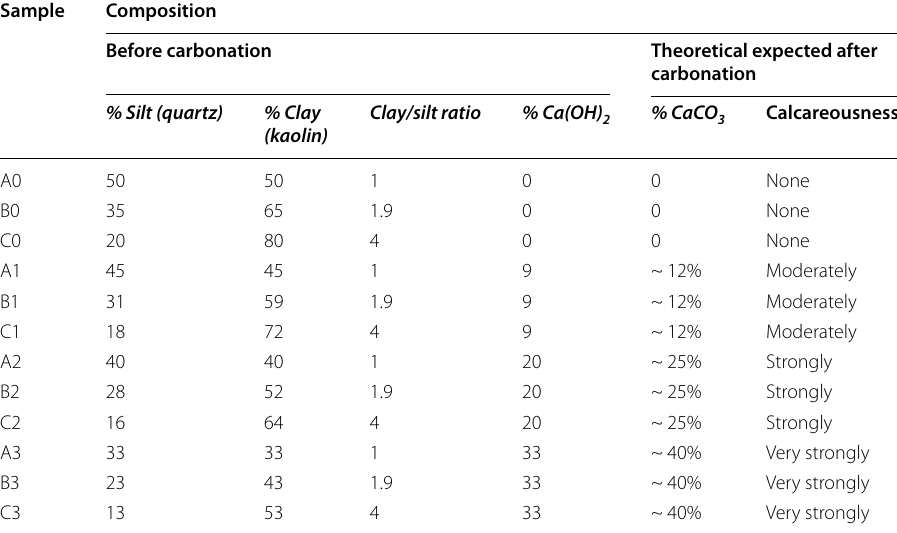
Table 1 Designed soil sample composition: degree of calcareousness defined according to Day’s 1983 classification of calcareous soils, cited in Kishchuk [27]